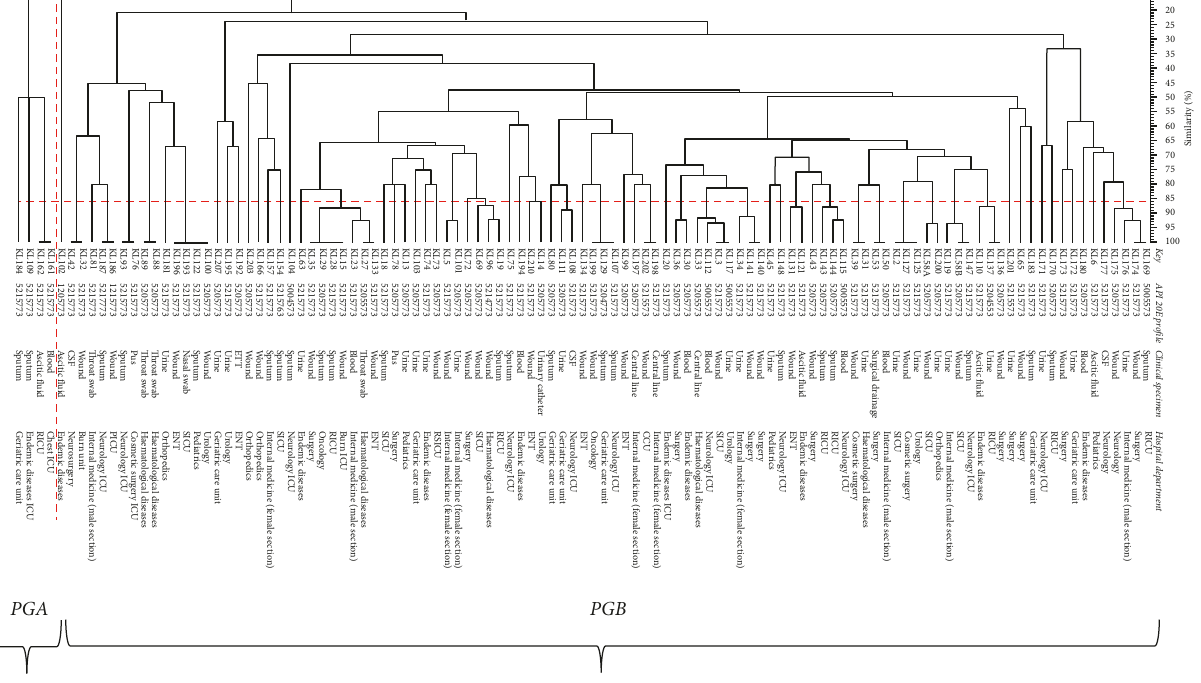
was detected among 14% (9/66) of tested isolates. A rmtB variant was not